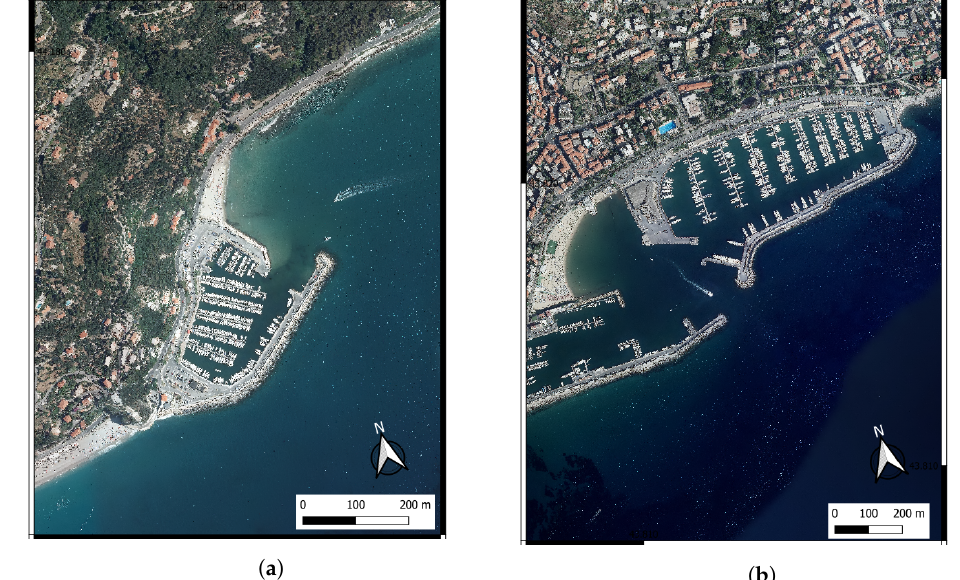
Figure 2. Aircraft orthophotos of the study areas: ( a ) Capo San Donato marina in Finale Ligure and ( b ) Portosole marina in Sanremo (orthophotos from Regione Liguria Geoportal).